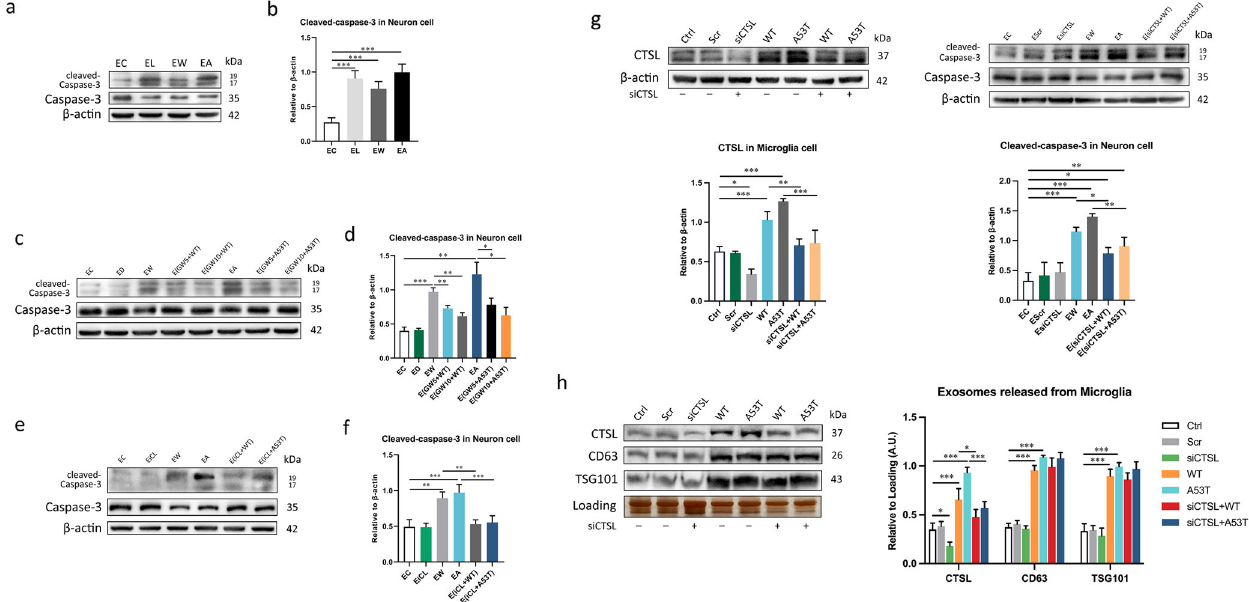
Fig. 5 CTSL-containing exosomes released from activated microglia promote apoptosis of neurons. a , b Primary cortical neurons were treated with exosomes isolated from microglia treated with or without WT or A53T α -Syn oligomer. Western blot and quantitative analysis of cleaved-caspase-3 expression in neurons treated for 24 h with exosomes from untreated microglia or microglia treated with LPS or WTor A53T α -Syn oligomer ( n = 3); ***p < 0.001. c , d The level neuronal apoptosis was determined after co-culture with exosomes from microglia pretreated with or without GW4869 ( n = 3); * p < 0.05, ** p < 0.01, *** p < 0.001. e , f The level of apoptosis of neurons cocultured with exosomes from microglia treated with or without iCL (n = 3); ** p < 0.01, *** p < 0.001. g Western blot and quantitative analysis of CTSL expression in microglia transfected with nonspeci fi c (scramble siRNA) (20 nM) or P2X7R siRNA (20 nM) to con fi rm CTSL knockdown. Exosomes secreted by α - Syn oligomers-activated CTSL knockdown microglia induce less neuronal death ( n = 3). h Densitometric analysis of the number of CTSL- containing exosomes released from microglia transfected with scramble or CTSL siRNA after treatment with WTor A53T α -Syn oligomer for 6 h ( n = 3); * p < 0.05, ** p < 0.01, *** p < 0.001. The amount of exosomes used in each group was secreted by approximately 3*10 7 microglia cells. Ctrl = untreated control; Scr = scramble; siCTSL = CTSL siRNA; EC = exosomes from untreated microglia (the control group); EL = exosomes from LPS-treated microglia; EW = exosomes from WT α -Syn oligomer-treated microglia; EA = exosomes from A53T α -Syn oligomer-treated microglia; ED = exosomes from DMSO-treated microglia; EiCL = exosomes from iCL-treated microglia; GW5 = 5 μ M GW4869; GW10 = 10 μ M GW4869; EsiCTSL = exosomes from CTSL knockdown microglia. Error bars represent